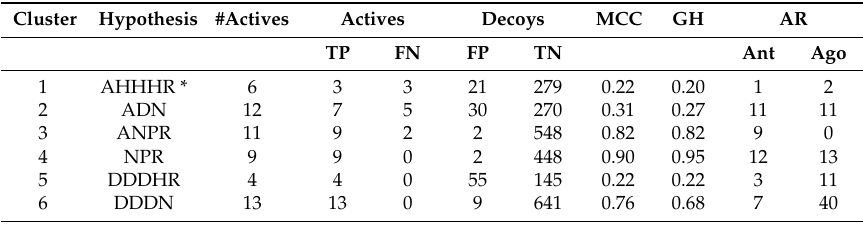
Table 1. The pharmacophore hypotheses with the number of active compounds (#Actives) in the cluster, the number of true positives (TP), false negatives (FN), false positives (FP) and true negatives (TN) obtained after mapping actives and DUD-E decoys to the pharmacophore model. These values were used to calculate the Matthews correlation coefficient (MC) and Goodness of Hit (GH). AR: number of actives retrieved after mapping all active compounds to the models. Abbreviations; Ant: antagonists, Ago: agonists. Feature abbreviations; hydrophobic feature: H, hydrogen bond acceptor feature: A, hydrogen bond donor feature: D, aromatic feature: R, positively charged feature: P, and negatively charged feature: